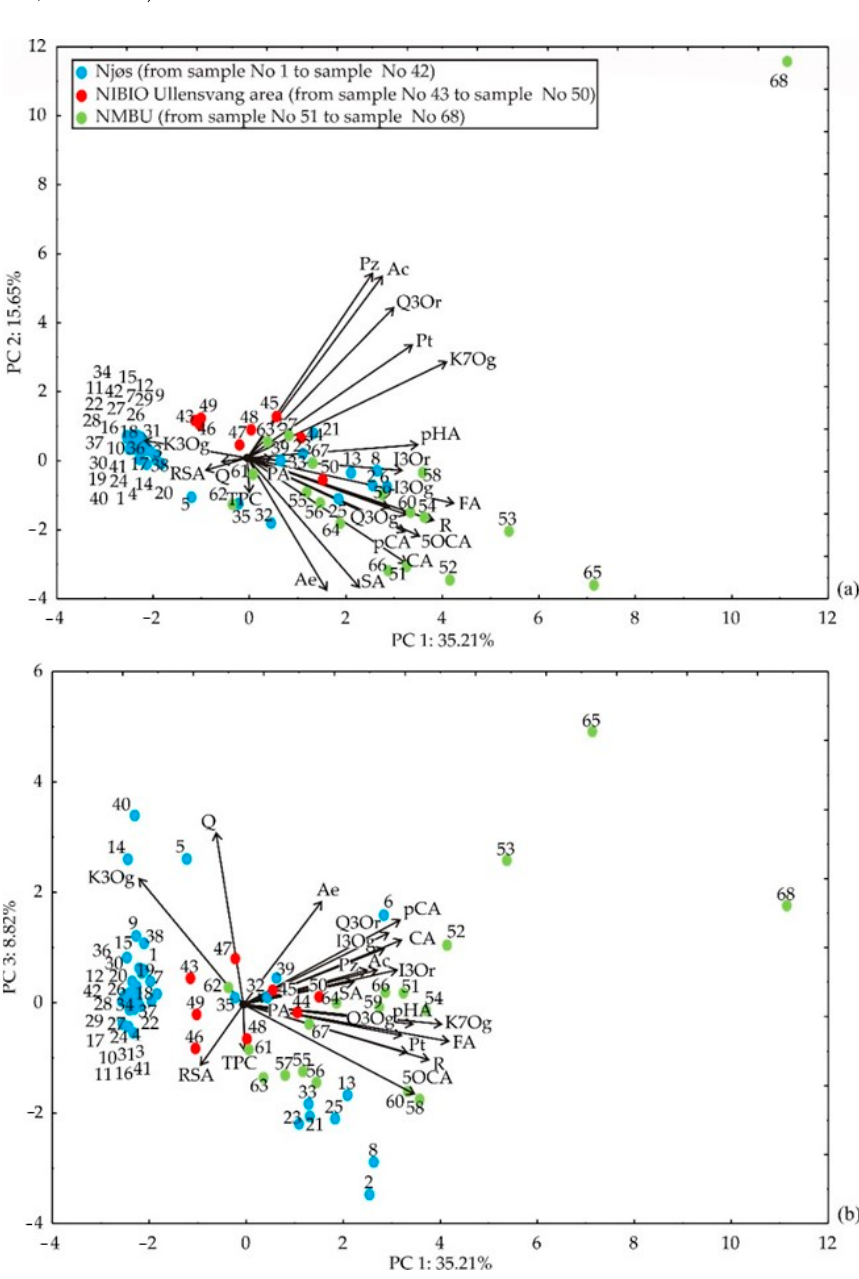
Figure 5. PCA ordination of phenolic content, TPC, and RSA variables: ( a ) projection in PC1-PC2 plane; ( b ) projection in PC1-PC3 plane (PA—protocatechuic acid, 5OCA—5- O -caffeoylquinic acid,